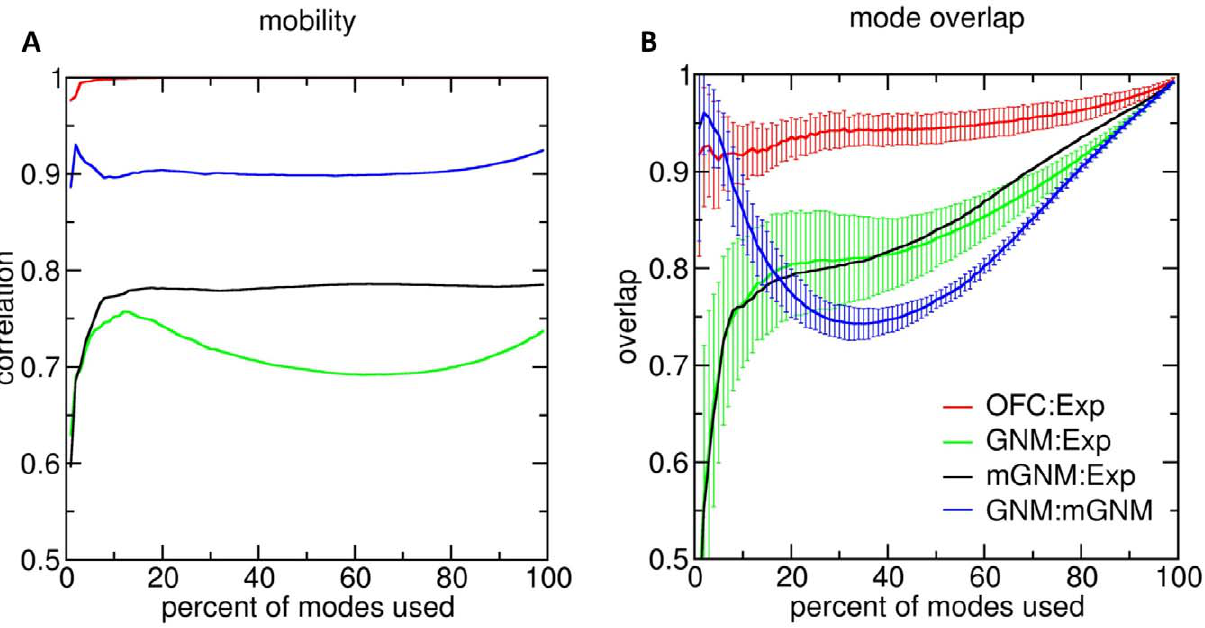
Figure 4. The effect of non-uniform force constants is manifested in the mid-range modes. The curves compare mobility (A) and mode overlap (B) of models as a function of the fraction of modes used. Black, green, and red curves compare the modes of the inverse covariance matrices from experiments to those obtained using mGNM, GNM, and optimized interactions (OFCs), respectively. The blue curves compare GNM modes to mGNM modes. For clarity, some error bars have been omitted. See text for